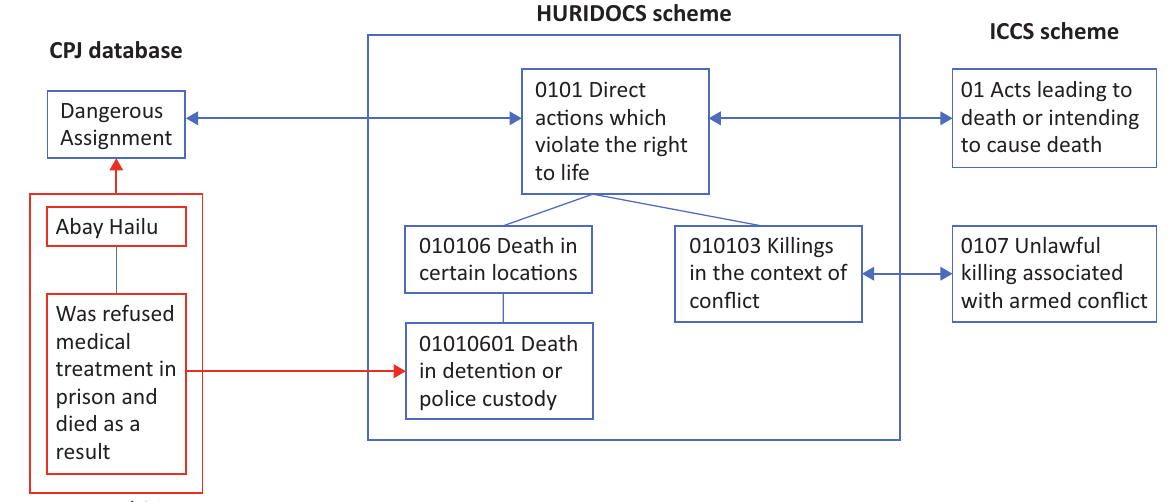
Figure 4. A conceptual structure for mapping